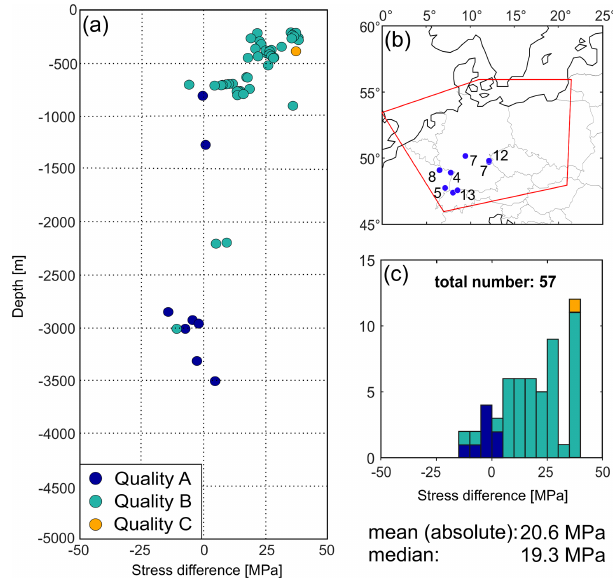
Figure 9. S Hmax magnitudes of the model in comparison to the data of Morawietz and Reiter (2020). The differences are calculated as model results minus calibration data. (a) Depth depending differ- ences. Color of dots indicates the quality of the calibration data. (b) Spatial distribution of the calibration data used, numbers indi- cating localities with multiple data used. (c) Histogram of the differ- ences displayed in (a) . Coastlines and borders used in the figures are based on the Global Self-consistent Hierarchical High-resolution Geography (GSHHG) of Wessel and Smith